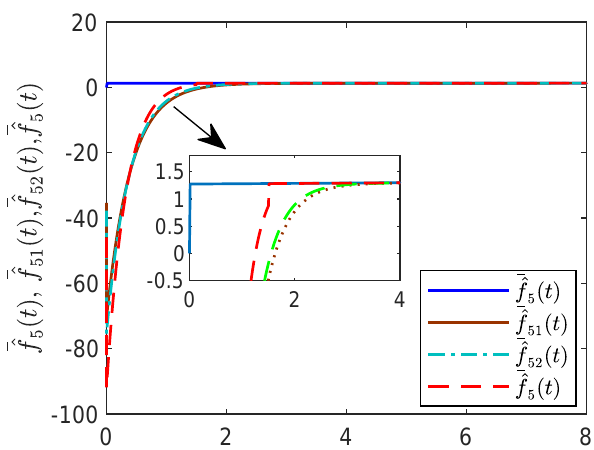
Figure 17. States (cid:107) w (cid:107) with and without